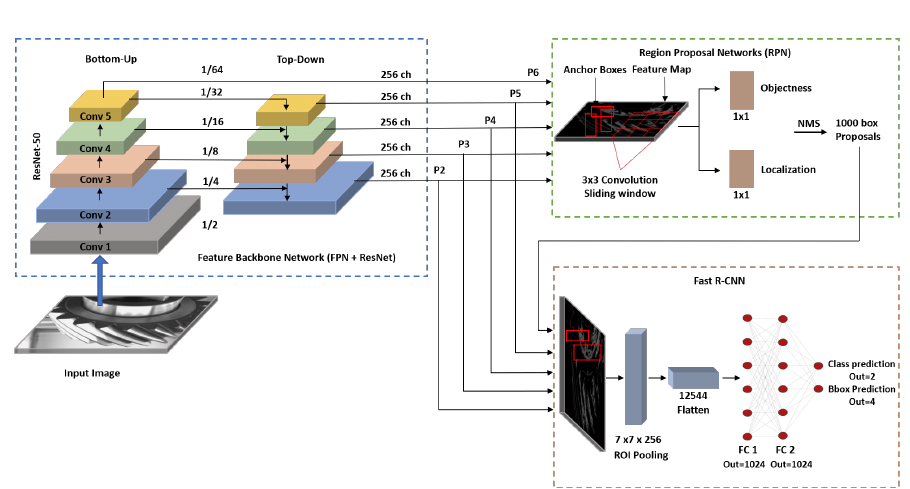
Figure 2. Faster R-CNN deep learning network for defect